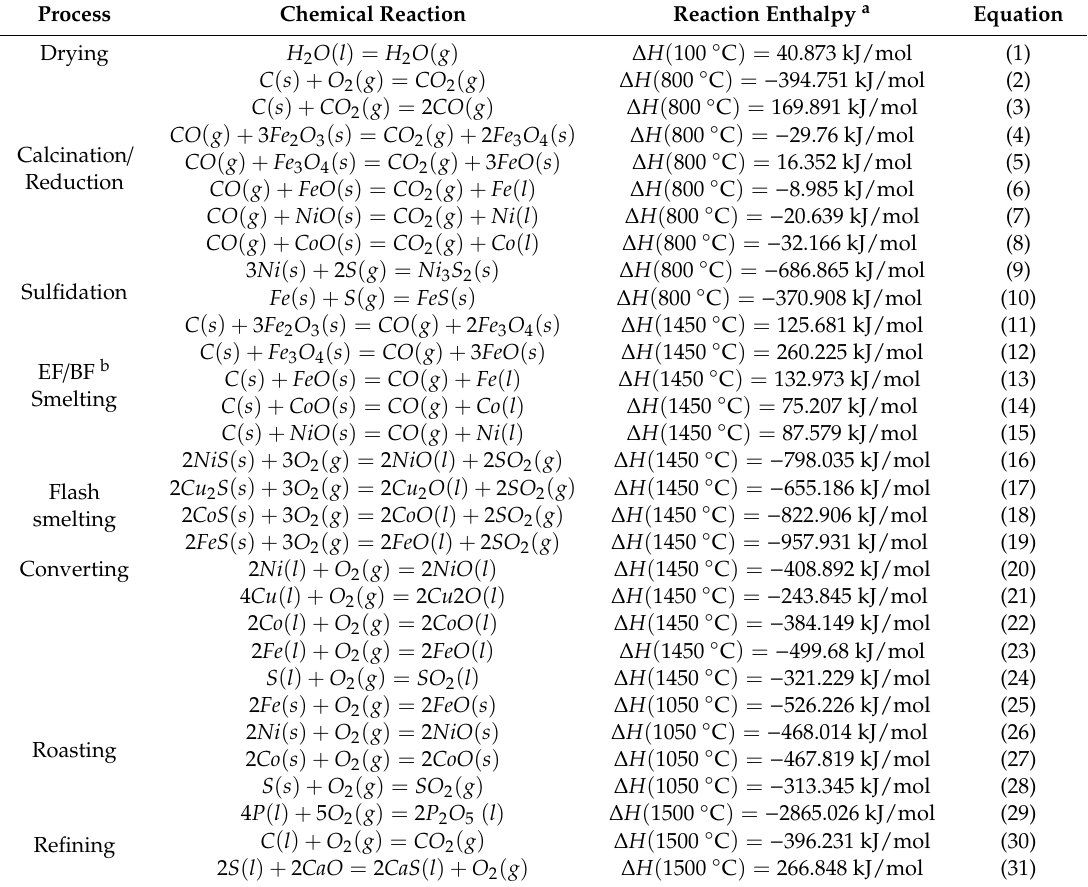
Table 2. Chemical reactions in nickel production